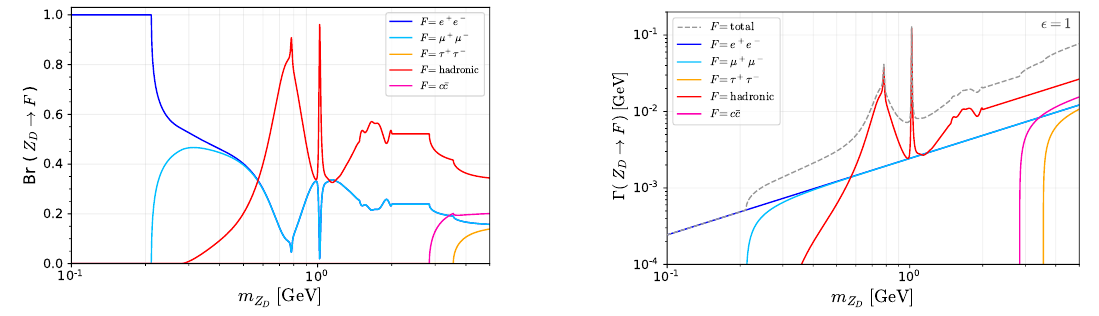
Figure 2 . The left panel shows the branching ratio of the dark photon into electrons (dark blue), muons (light blue), taus (orange), hadrons and light quarks (red) and c ¯ c (pink). The right panel shows the dark photon total (dashed) and partial (solid) decay widths for a fixed kinetic mixing parameter (cid:15) = 1